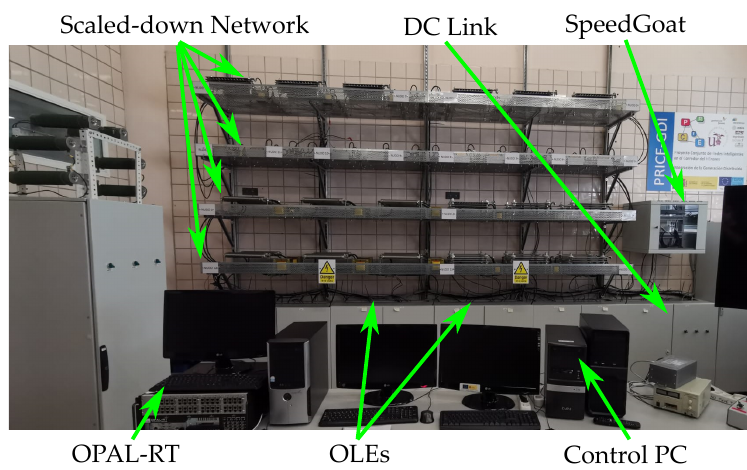
Figure 4. PSHIL layout of the Department of Electrical Engineering at the University of